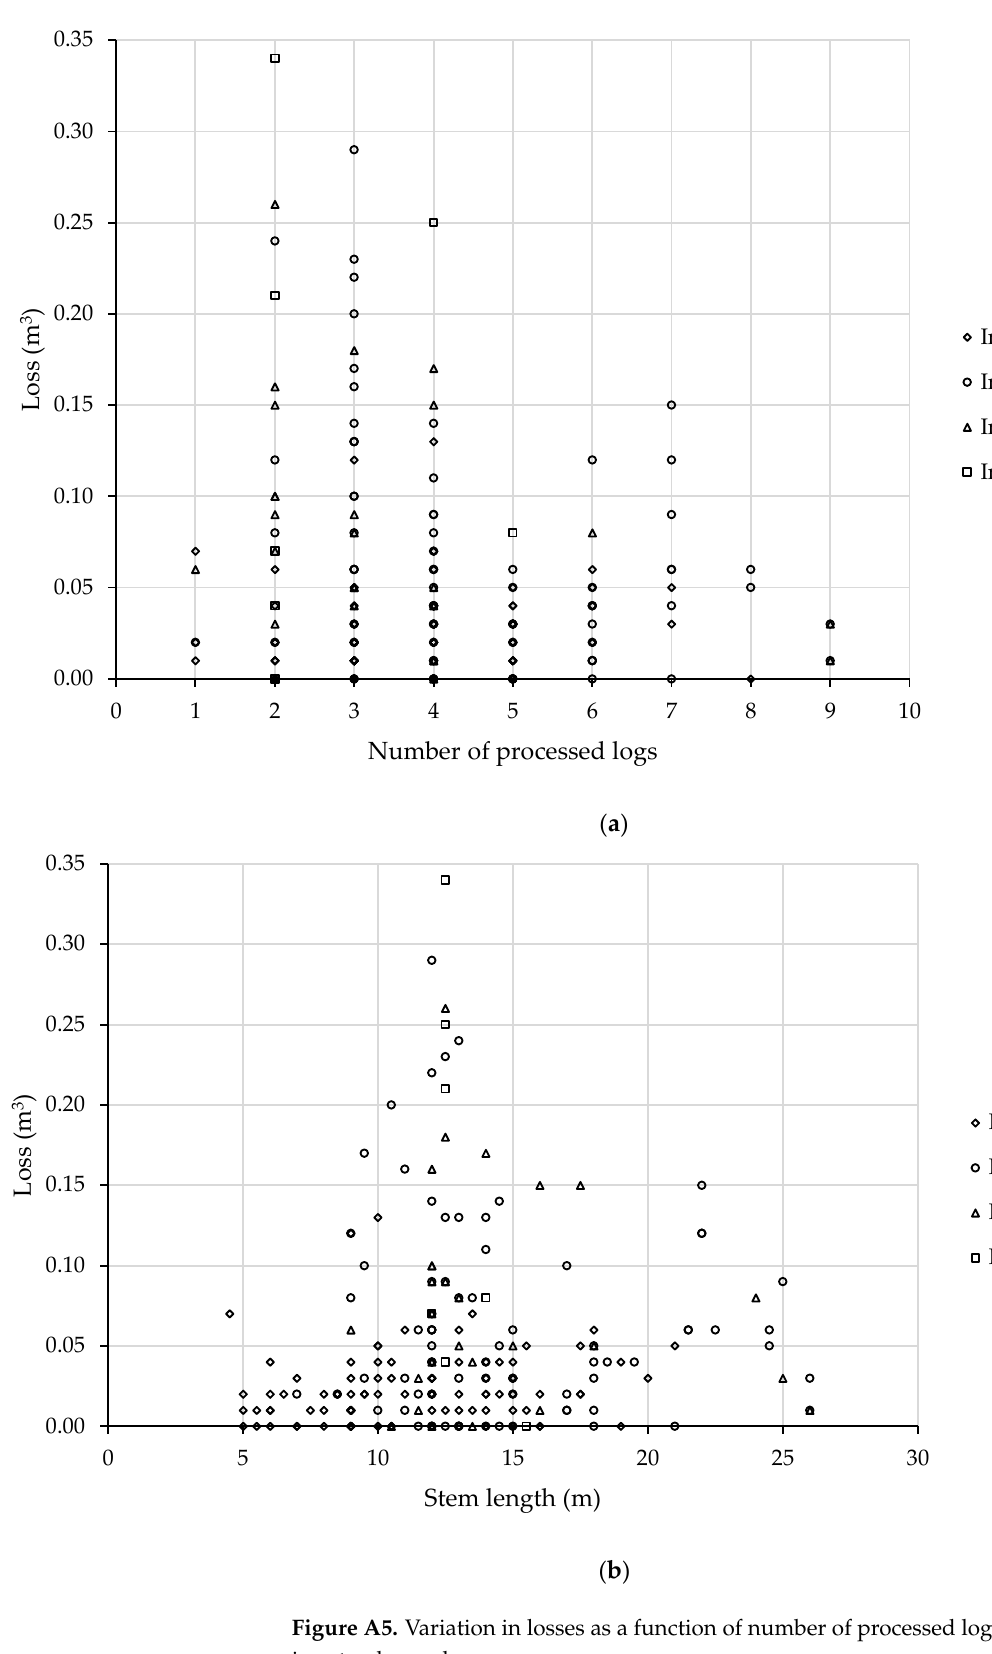
Figure A4. Scatter plots of the variation in net efficiency and productivity plotted against the rele- vant input and output variables: ( a ) efficiency against stem length; ( b ) efficiency against number of processed logs; ( c ) productivity against stem length; ( d ) productivity against number of processed logs; Note: data have failed normality and homoskedasticity assumptions.